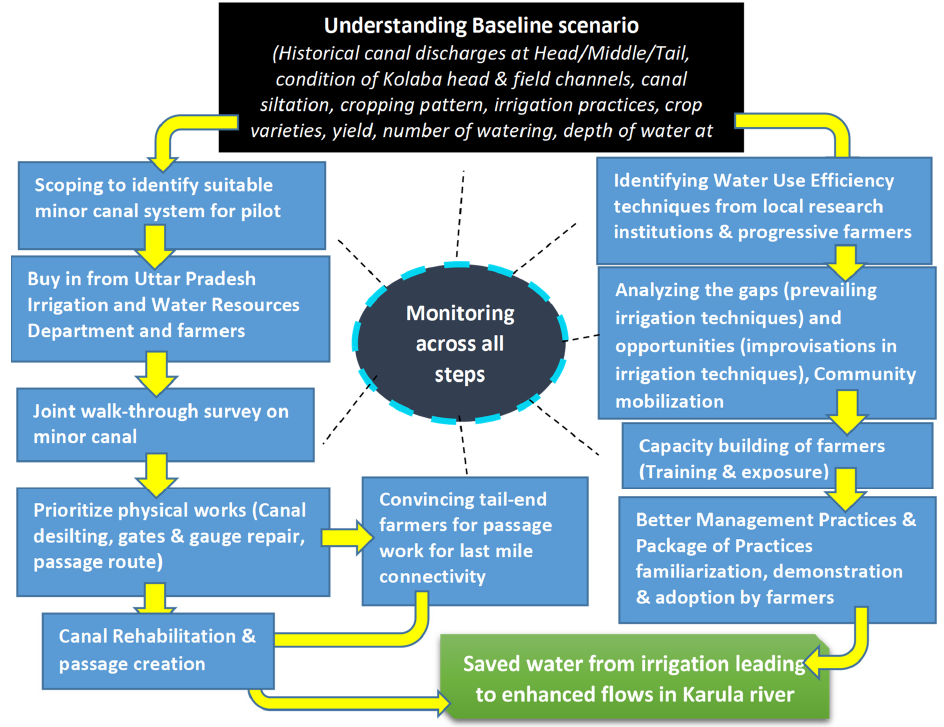
Figure A3. Illustration of Combination of Supply-Side and Demand-Side Interventions Leading to Figure A4. Illustration of Combination of Supply ‐ Side and Demand ‐ Side Interventions Leading to Enhanced Flows in Karula. Enhanced Flows in